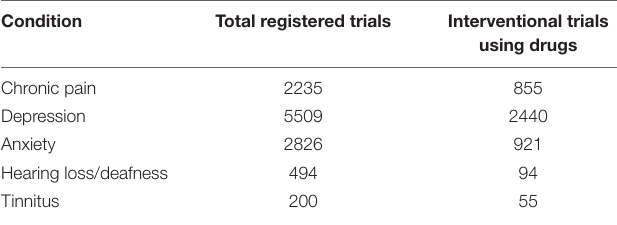
TABLE 1 | A list of trials registered on the clinicaltrials.gov website, showing both total number of trials and those trials investigating drug interventions for the relevant condition (such conducted